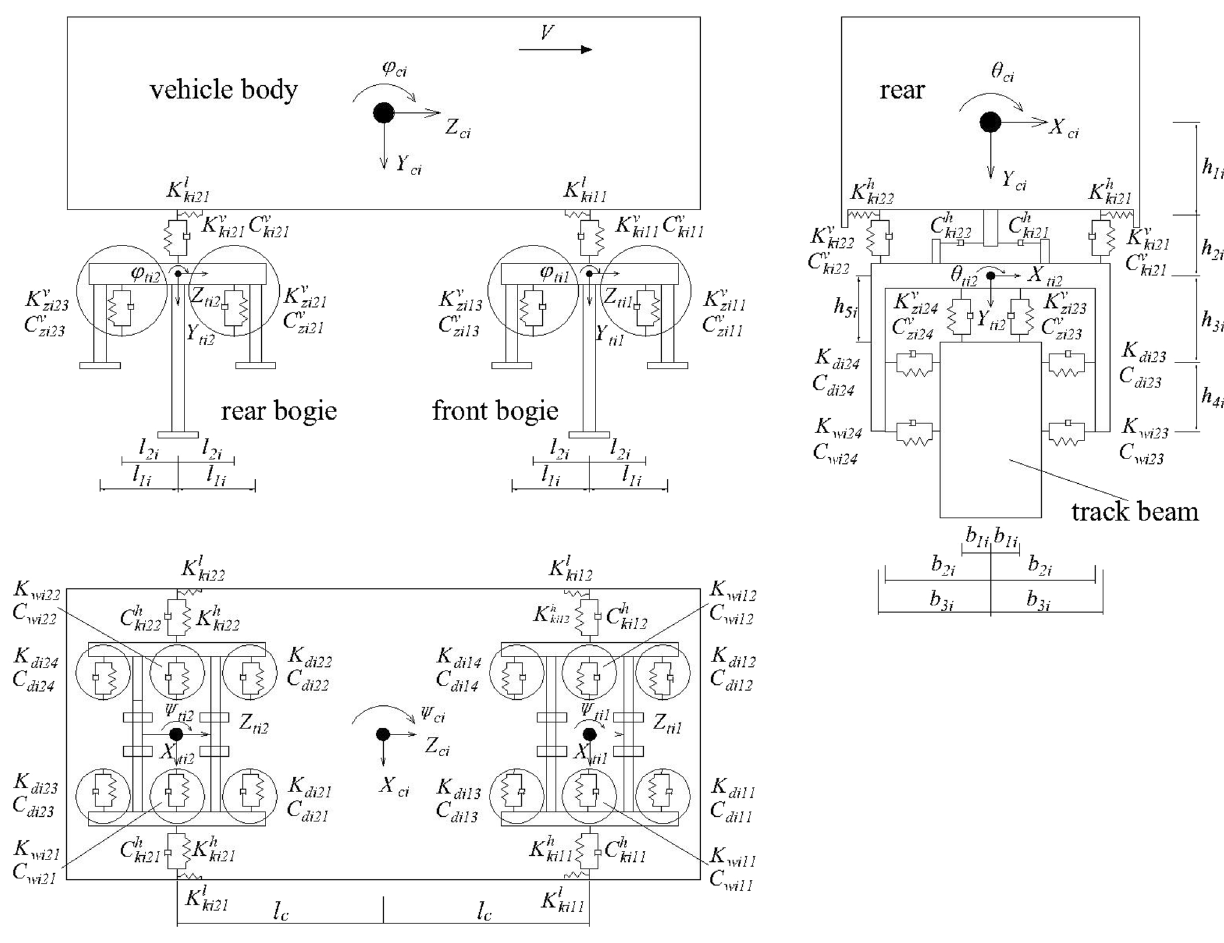
Fig. 4 Diagram of monorail vehicle simplified dynamics model Table 1 Notations of